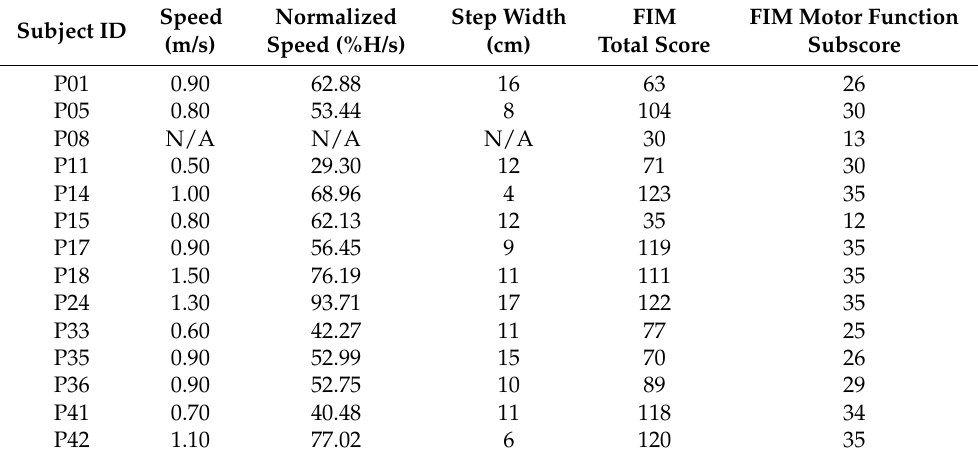
Table 3. Walking speed, normalised walking speed, and functional independence measure (total score and motor function subscore) obtained for DS